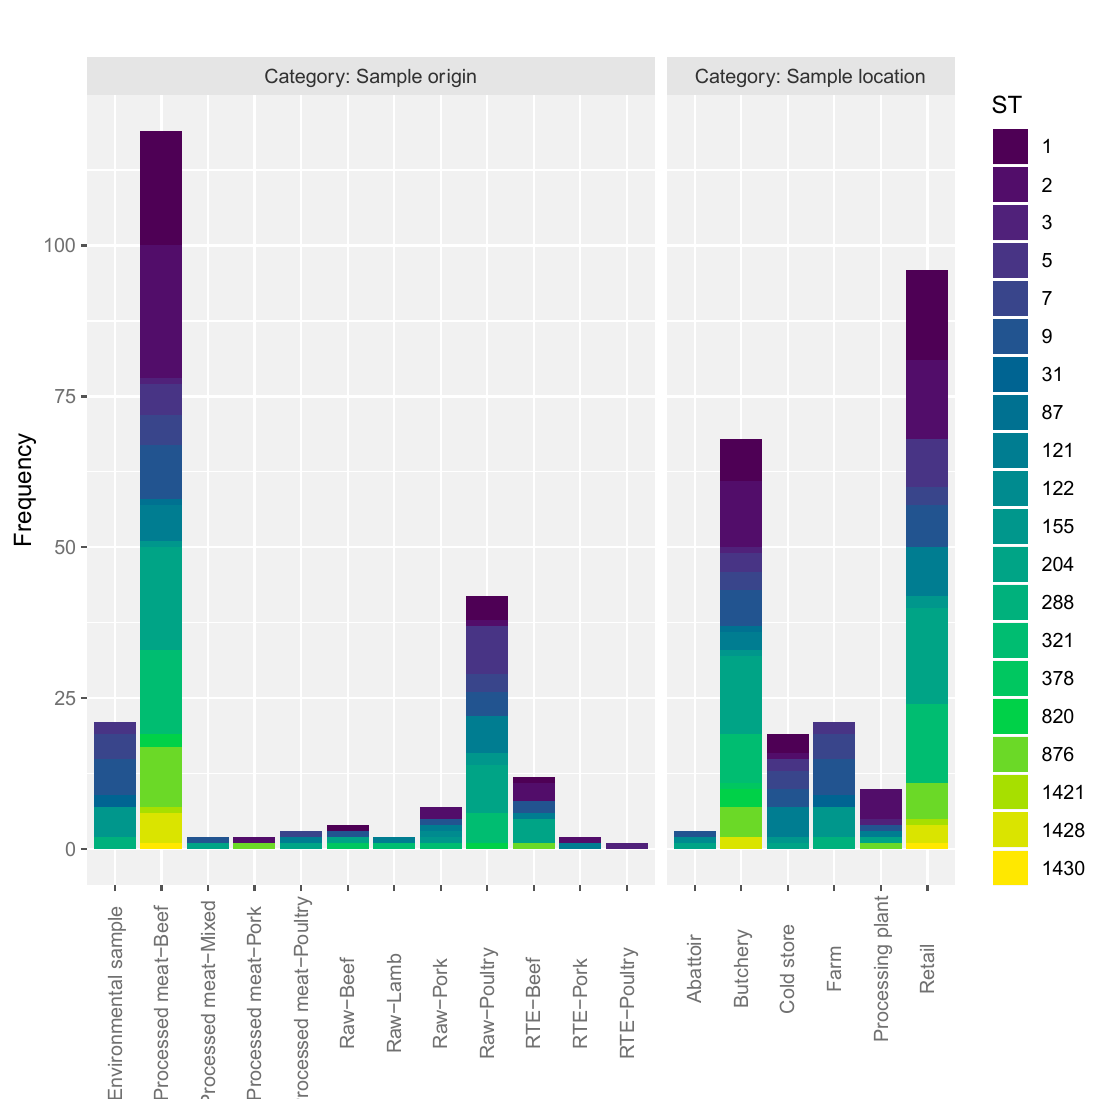
Figure 4. Frequency of STs per sample collection category . Table 2. Diversity indices based on the occurrence of STs in the different categories.